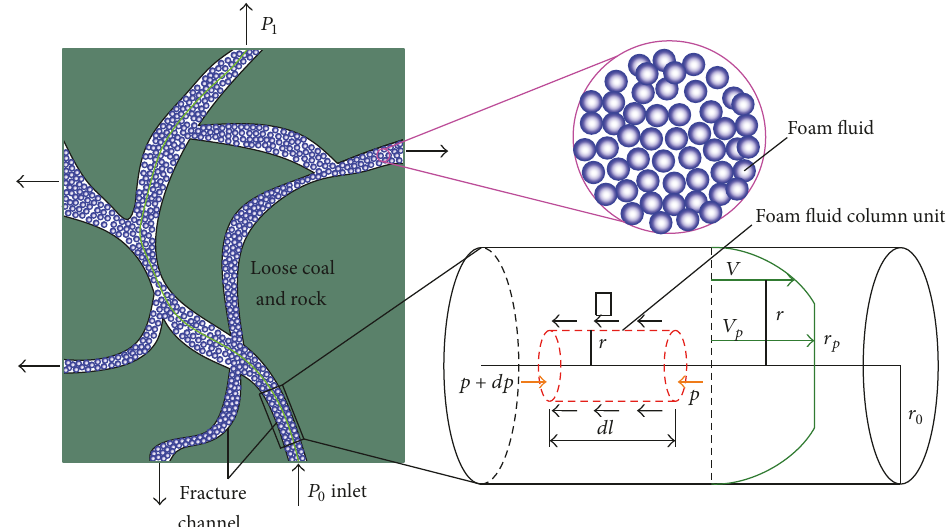
Figure 9: Schematic of the column flow of a unit of foam fluid in a fracture